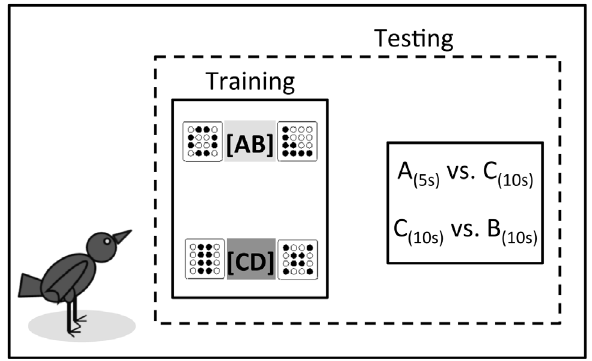
Figure 1. Experimental design schematics. Animals were trained in two alternating contexts. In context [AB], they encountered options A 5s or B 10s in random alternation; in context [CD], they met C 10s or D 20s ( Training ). The animals were then tested by introducing, infrequent simultaneous choice trials between options that belonged to different contexts, namely between A 5s and C 10s and between B 10s and C 10s ( Testing ). Delay to food in each option is denoted, in seconds, by the suffixes; symbols exemplify the type of stimuli